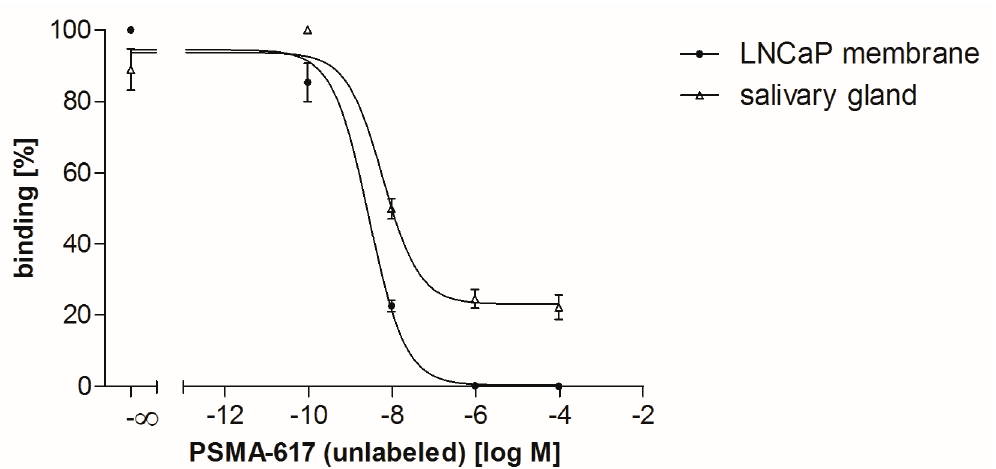
Figure 3. Competitive binding studies of PSMA-617 on LNCaP membrane pellets and pig salivary gland tissue. 6 nM radioligand ([ 177 Lu]Lu-PSMA-617) were incubated with increasing concentrations (0.1 nM–100 µ M) of PSMA-617 (unlabeled) as competitor for 1.5 h at ambient room temperature. Autoradiography was performed with a Cyclone Plus Phosphorimager after an exposure time of 48 h.